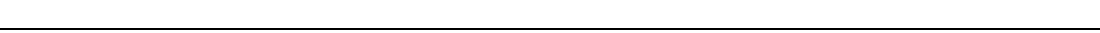
Figure 2 draws (a) the cross-sectional device structure and (b) numerically simulated cross-sectional THz photon fi eld distribution of its in-plane electric fi eld intensity compo- nent even when the SiC substrate is thinned down to a 25 µm thickness. Due to the effect of the high-permittivity SiC substrate underneath the graphene (situated the top surface of the SiC substrate) the fi eld of spontaneously emitted THz photons from the population-inverted gra- phene channel layer sank into the SiC substrate